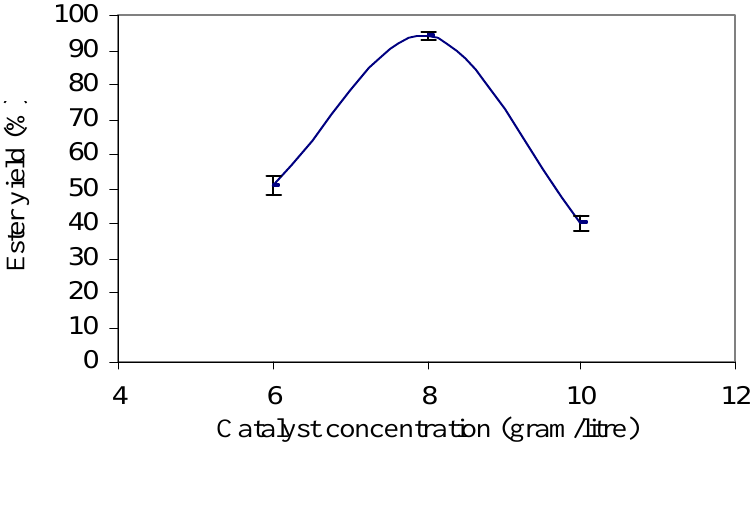
Figure 2. Conversion efficiency of ester under different catalysts